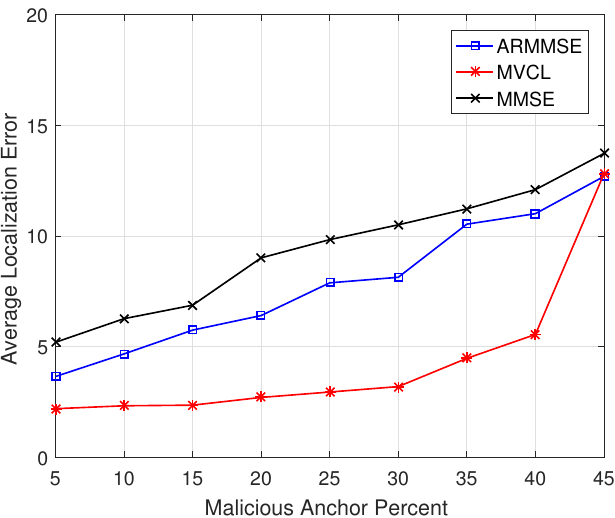
Figure 16. Average localization error with malicious anchor percent p ( n = 80, m = 20, R = 30, ζ = 15, η =